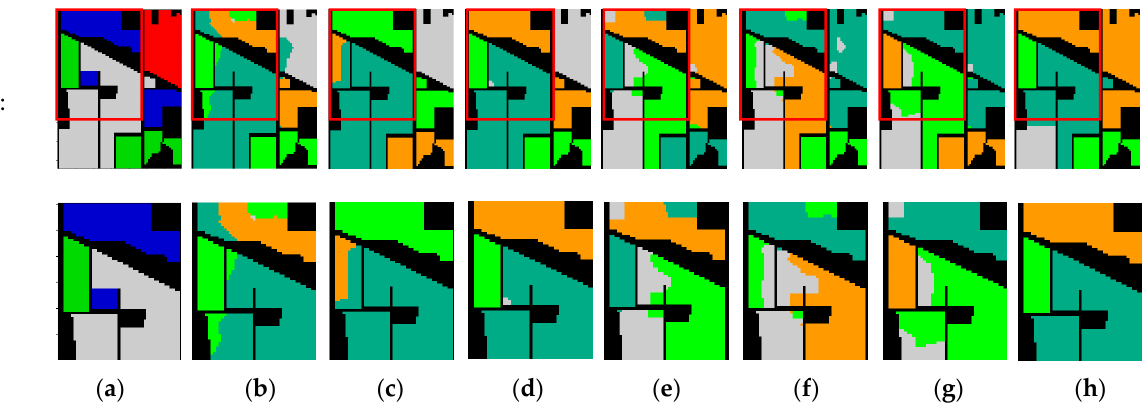
Figure 3. Clustering results obtained using different methods on the Indian Pines corrected data set. ( a ) Ground truth. ( b ) LRSC 57.52%. ( c ) SSC 56.09%. ( d ) S4C 64.97%. ( e ) EDSC 70.26%. ( f ) EGCSC 88.27%. ( g ) EKGCSC 97.31%. ( h ) SSAKGCSC 97.43%.